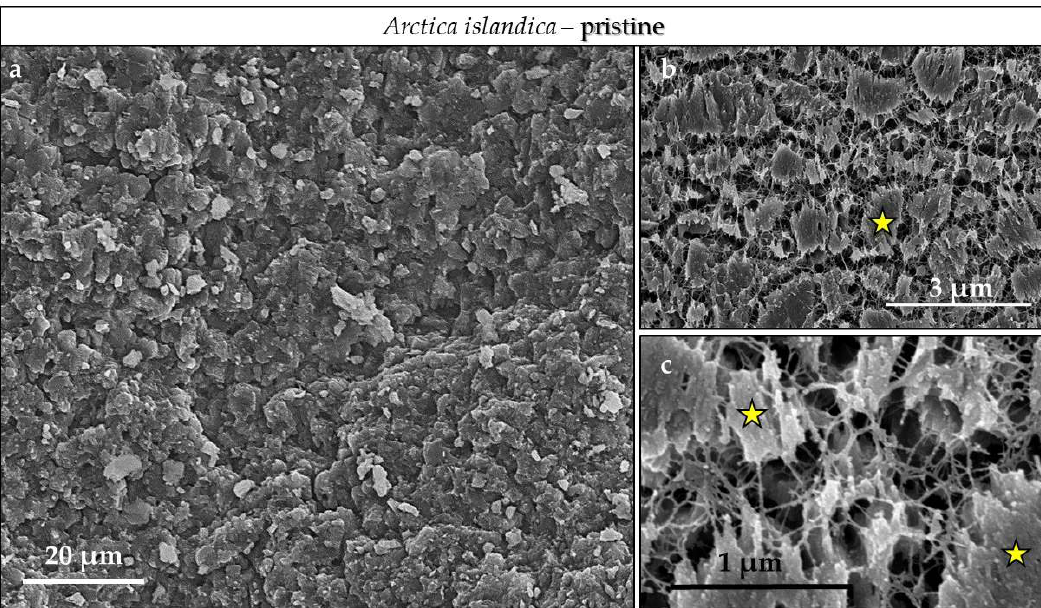
Figure A6. FE-SEM images of ( a ) aragonite crystallites and ( b , c ) mineral unit morphologies in pristine Arctica islandica , where mineral units are embedded into a network of biopolymer fibrils. Aragonitic mineral units are larger in size in the shell portion facing seawater relative to that part of the shell that is next to the soft tissue of the animal.